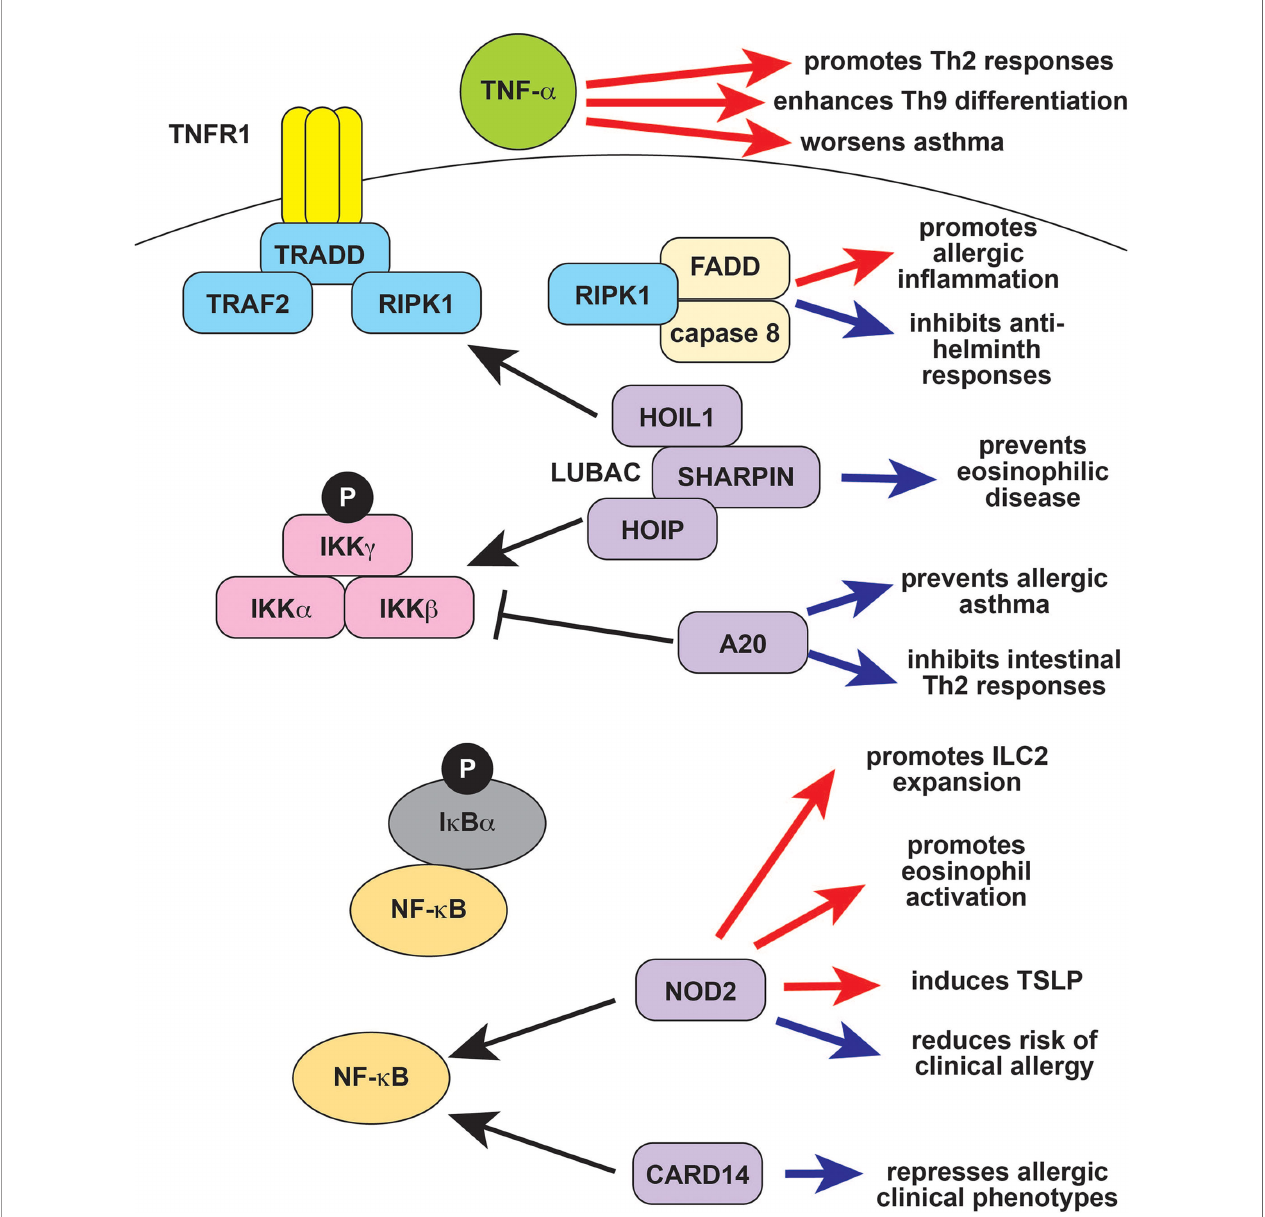
FIGURE 2 | TNF- a and NF- k B signaling in type 2 immune responses. TNF- a exacerbates type 2 diseases like asthma in part by promoting Th9 and Th2 differentiation and function (red arrows). The protease caspase-8 forms the ripoptosome complex together with the TNF signaling molecule RIPK1 and FADD. The ripoptosome is regulates cell death, with caspase-8 and RIPK1 promoting apoptosis over necroptosis, so that defects in RIPK1 result in increased necroptosis and autoin fl ammation. The ripoptosome promotes type 2 responses in response to environmental allergens (red arrow) but can suppress type 2 responses to parasites (blue arrows). Ubiquitin editing proteins like A20 ( TNFAIP3 ) and LUBAC (composed of HOIL-1, HOIP, and SHARPIN) modulate NF- k B signaling by targeting upstream molecules for activation and/or degradation. A20 negatively regulates NF- k B and also prevents allergic asthma as well as other type 2 responses (blue arrows). SHARPIN activates NF- k B, and de fi ciency results in eosinophilic tissue in fi ltration (blue arrow). The NF- k B signaling molecules CARD14 and CARD15/NOD2 also modulate type 2 responses. CARD14 prevents allergic disease, and de fi ciency results in clinical atopy (blue arrow). CARD15/NOD2 is reported to have both positive (red arrows) and negative (blue arrows) effects on type 2 immunity, and its role may be context-dependent. TNF- a , tumor necrosis factor alpha; RIPK1, Receptor Interacting Serine Threonine Kinase 1; FADD, Fas Associated via Death Domain; LUBAC, linear ubiquitin chain assembly complex; HOIL-1, Haem-Oxidized IRP2 Ubiquitin Ligase 1; HOIP, HOIL-1L Interacting Protein; SHARPIN, SHANK-associated RH-interacting protein; TNFAIP3, TNF- a induced protein 3; CARD14, caspase recruitment domain-containing protein 14; CARD15, caspase recruitment domain-containing protein 15; NOD2, nucleotide binding oligomerization domain- containing protein 2; Th2, T helper 2; IL-9, interleukin 9; IL-13, interleukin 13; IL-4, interleukin 4; NK, natural